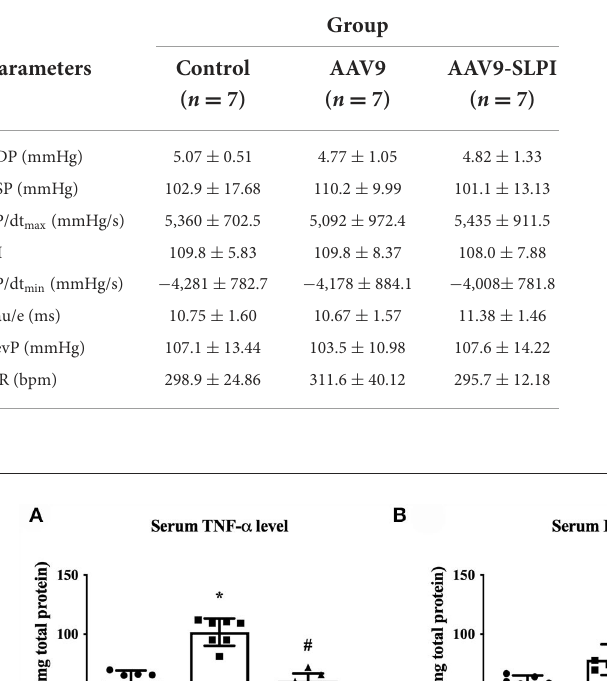
TABLE 2 Effect of AAV9-SLPI on LVP parameters in I/R rats at the end of reperfusion period.